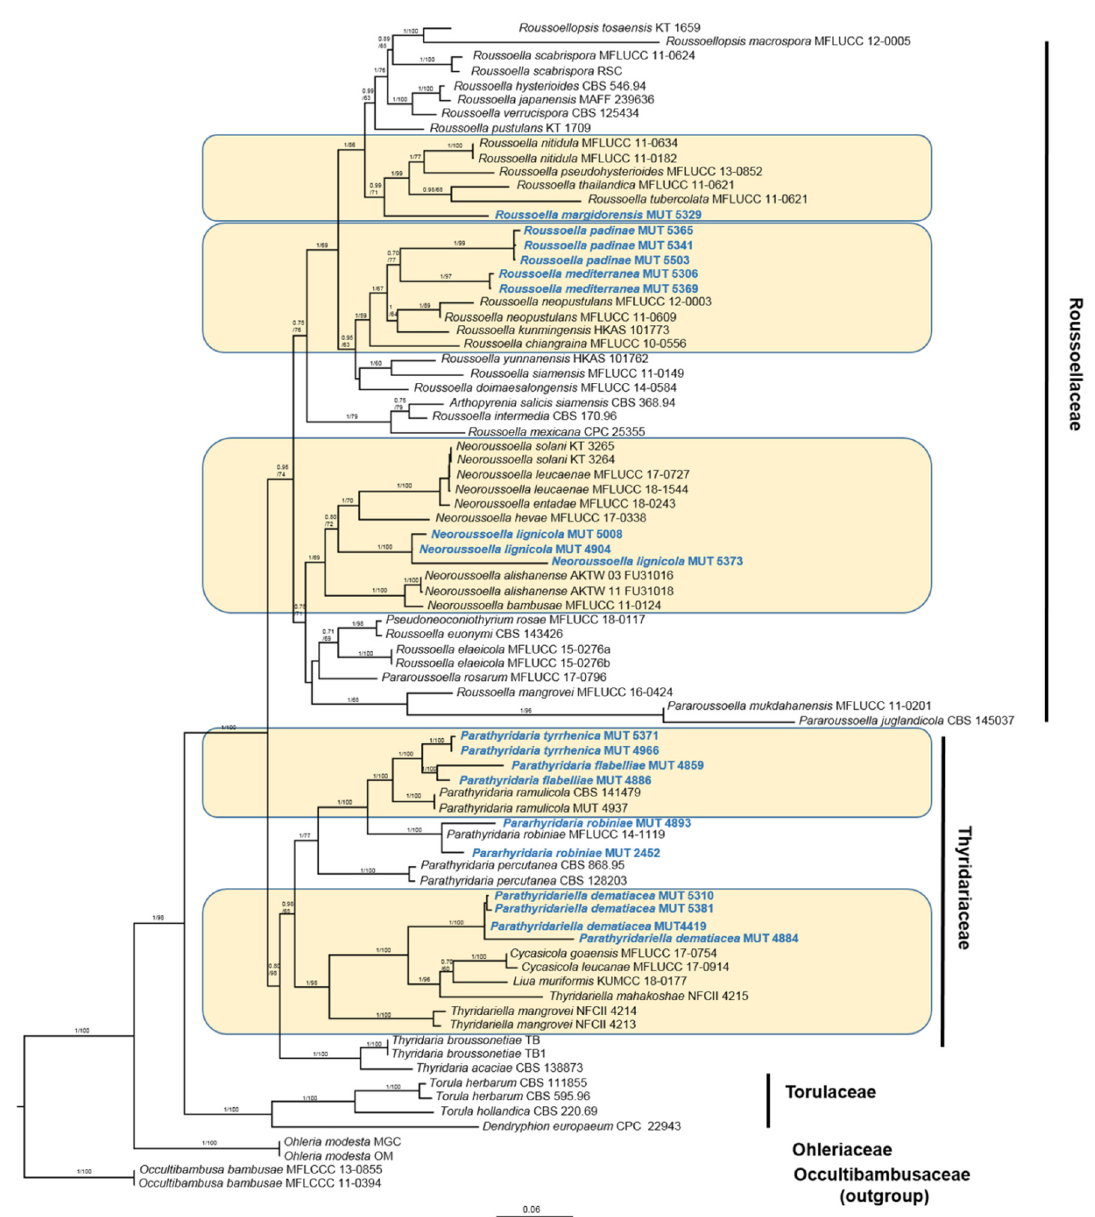
Figure 1. Phylogram generated from RAxML analysis based on a combined dataset of nrITS, nrSSU, nrLSU, TEF1 α and RPB2 partial sequences. The tree is rooted to Occultibambusa bambusae. Branch numbers indicate BYPP/MLB values; Bar = expected changes per site (0.06).